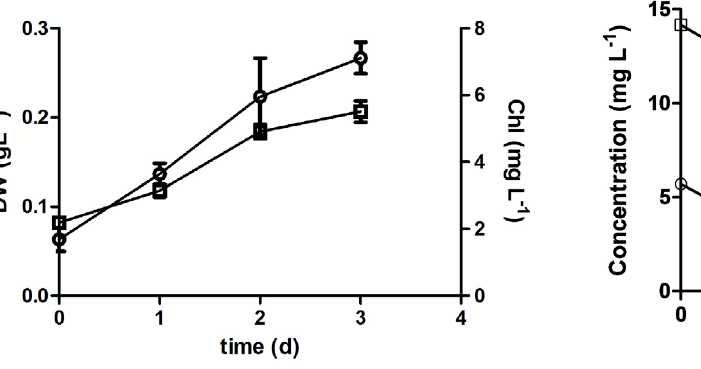
Figure 5: Growth of C . vulgaris in real wastewater (○) Dry weight (□) Chlorophyll